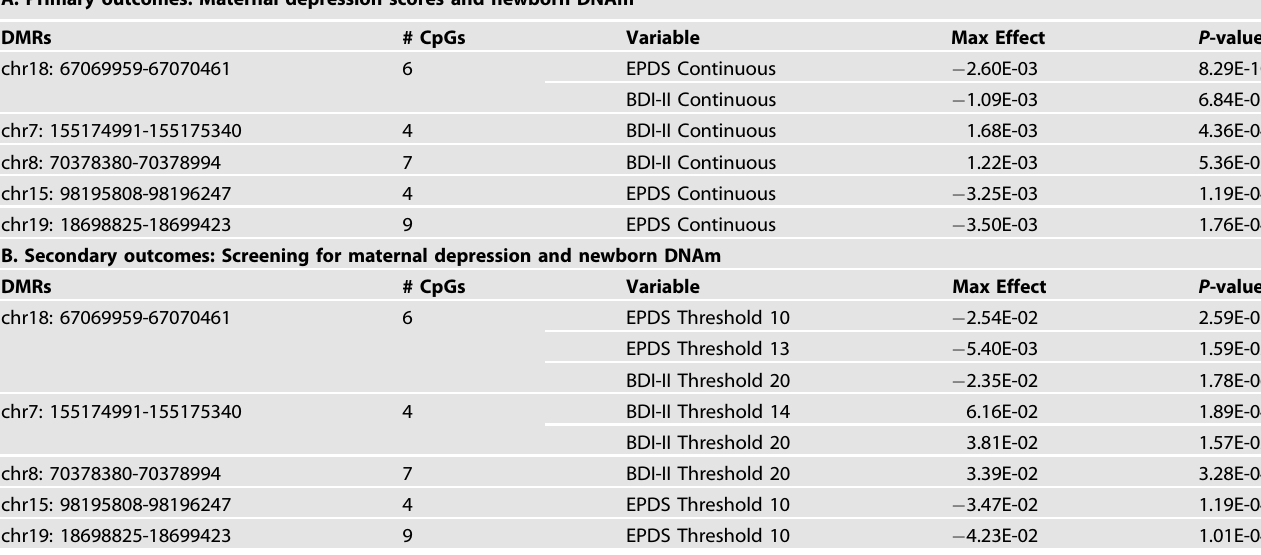
Table 3. Max effect sizes and p-values from a meta-analysis using DMRcate for DMRs signi fi cant in two or more depression